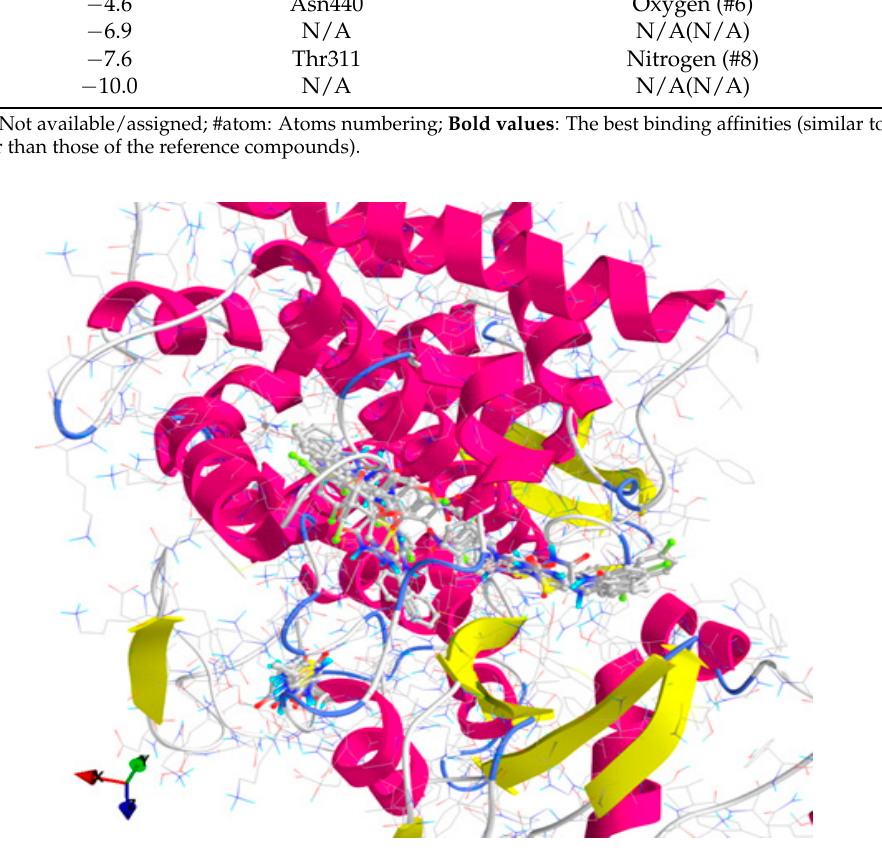
Figure 3. General view of docking poses of the screened compounds in the active site of